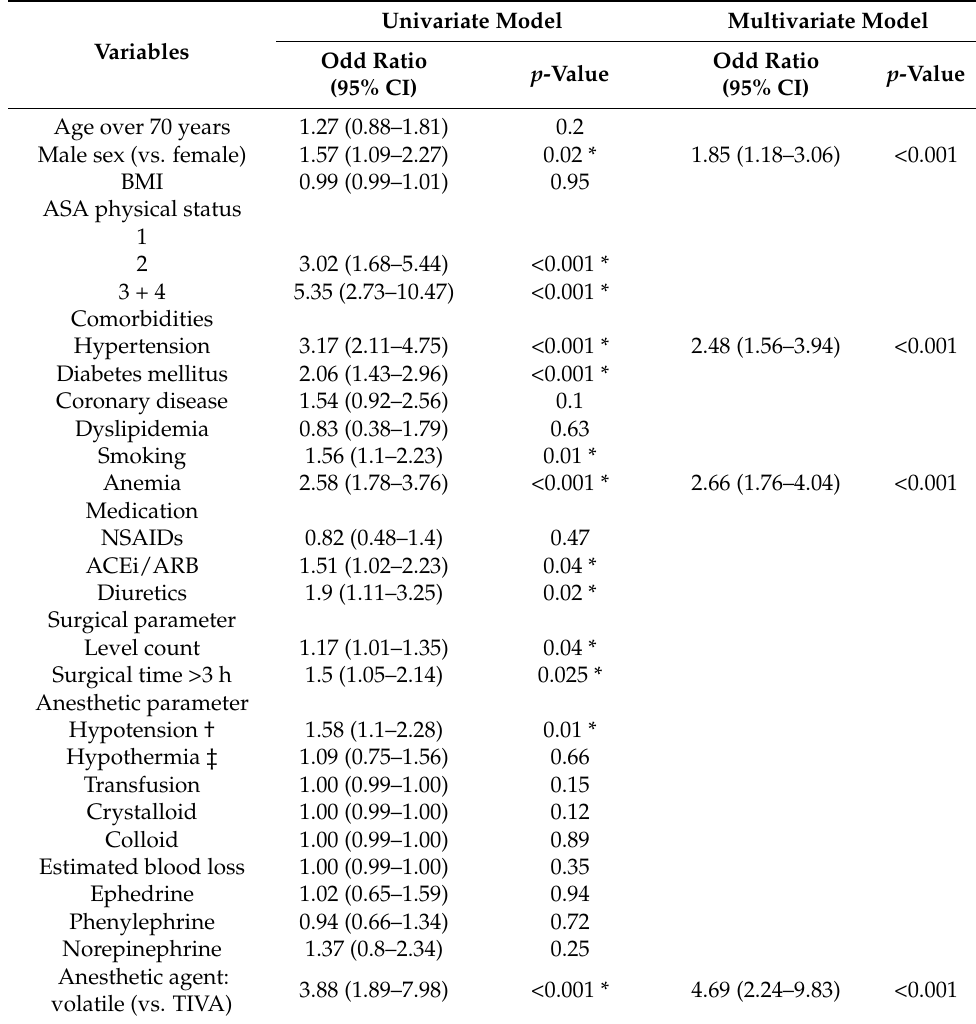
Table 3. Univariate and multivariate logistic regression analysis for the occurrence of postoperative acute kidney injury after spine surgery. Univariate Model Multivariate Variables